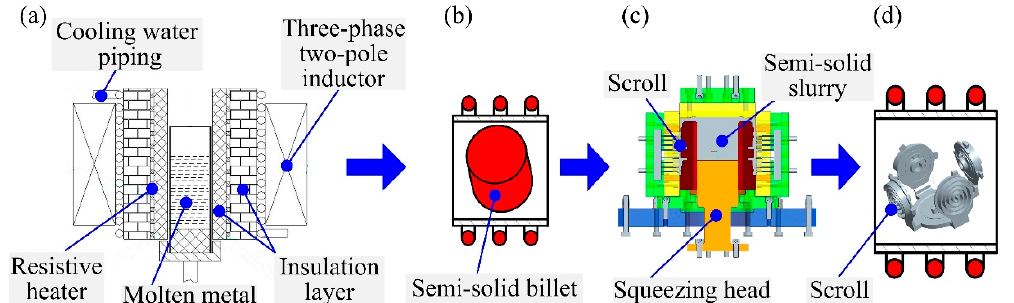
Figure 2. Electromagnetic stirring (EMS)-based semisolid multicavity (SMSC) process of one mold for four aluminum alloy scrolls: ( a ) Stage—EMS preparation, ( b ) Stage II—remelting, ( c ) Stage III—forming process, and ( d ) Stage IV—T6 heat treatment.